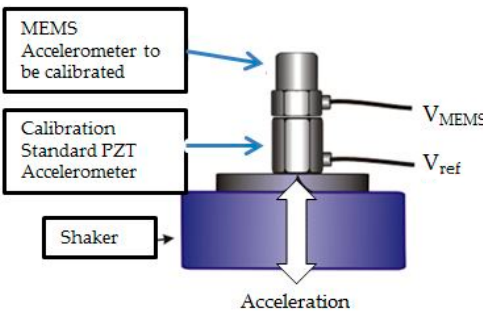
Figure 5. The back-to-back calibration method. PZT: lead zirconate titanate; V MEMS : the output voltage of MEMS accelerometer; V ref : the output voltage of reference PZT accelerometer.